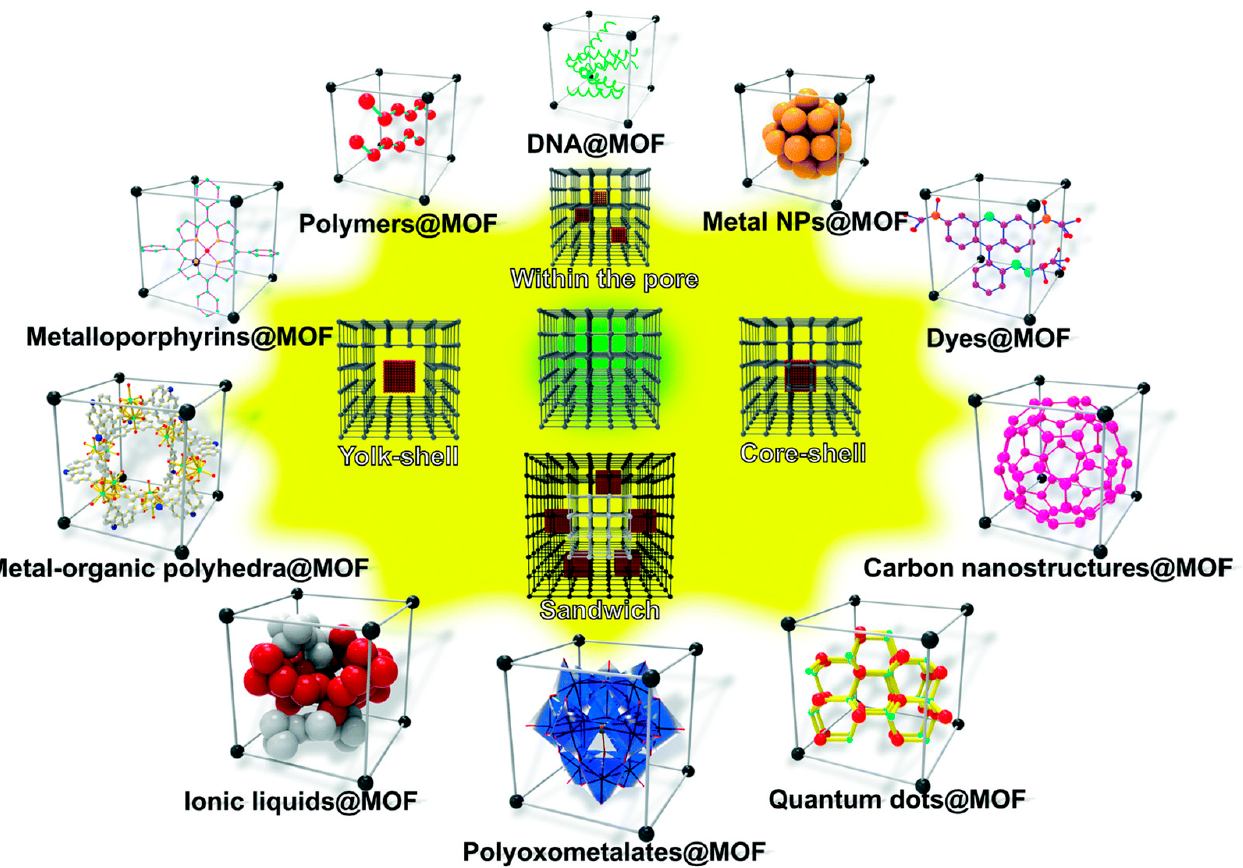
Figure 2. The schematic of incorporated MOF with various materials (reproduced with permission from ref [24]).